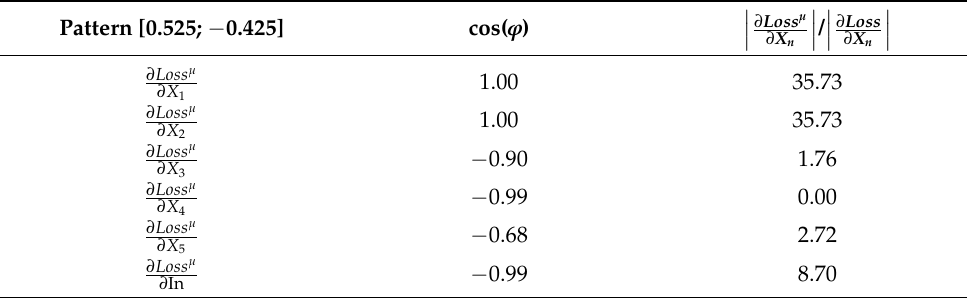
Table 2. The data taken from the best learnt pattern ( x = 0.525, and y = − 0.425). Pattern [0.525; −